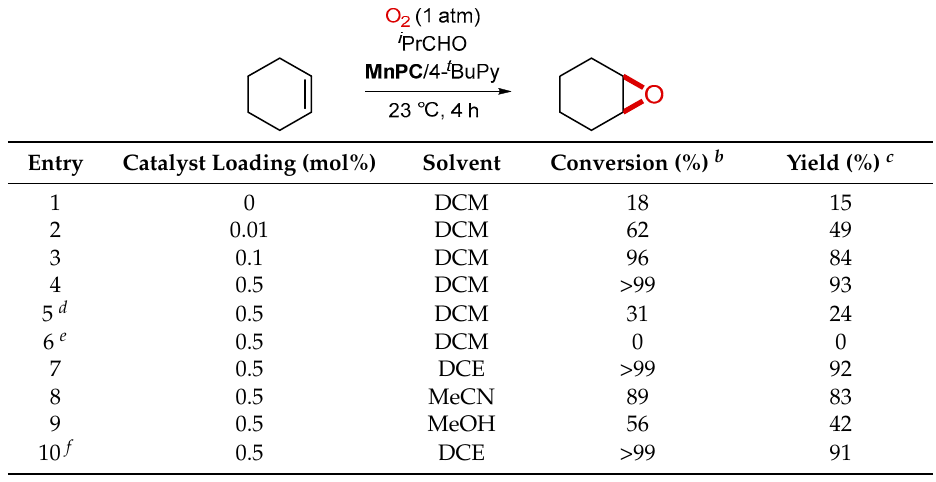
Table 1. Aerobic epoxidation of cyclohexene catalyzed by manganese porphyrin cage catalyst MnPC in the presence of isobutyraldehyde. a